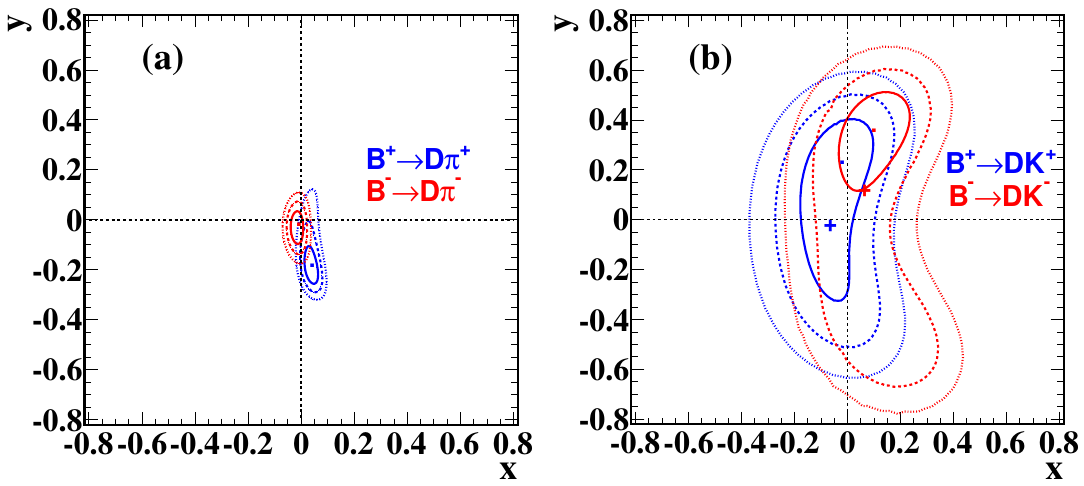
Figure 6 . One (solid line), two (dashed line), and three (dotted line) standard deviation likelihood contours for the ( x (cid:6) ; y (cid:6) ) parameters for (a) B (cid:6) ! D(cid:25) (cid:6) and (b) B (cid:6) ! DK (cid:6) decays. The point marks the best (cid:12)t value and the cross marks the expected value from the world average values of (cid:30) 3 , r DK , and (cid:14) DK B B